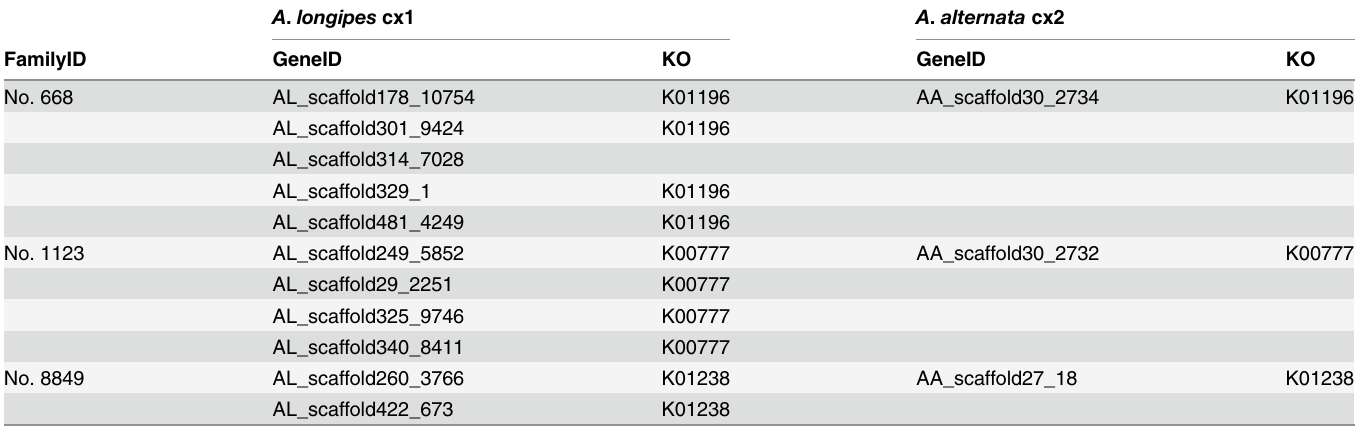
Table 3. Three gene families specific to A . longipes cx1 and A . alternata cx2 have different gene copies between these two